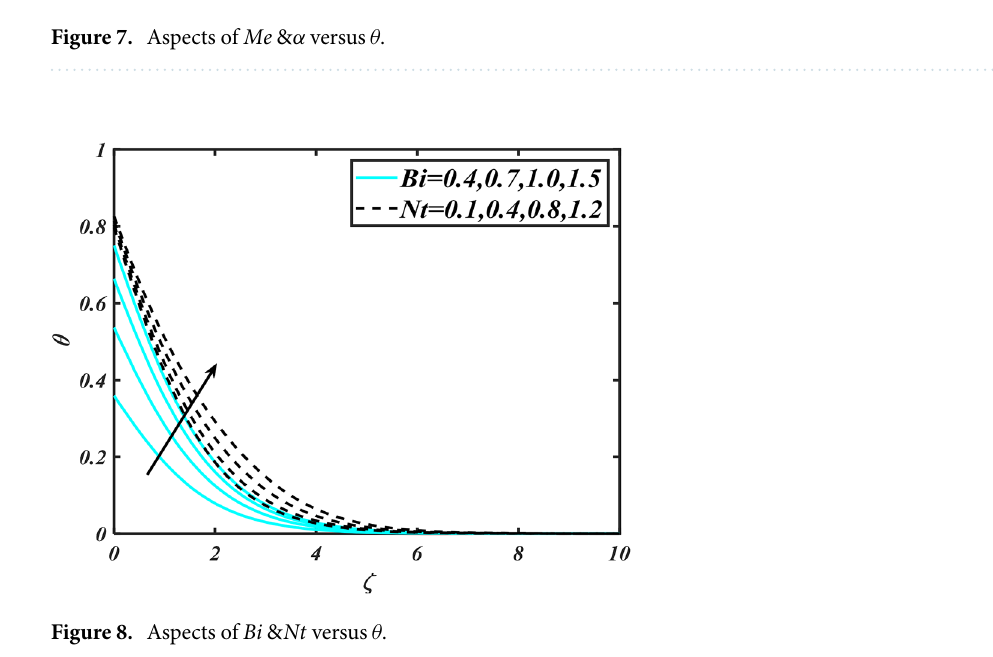
Figure 8. Aspects of Bi & Nt versus θ .